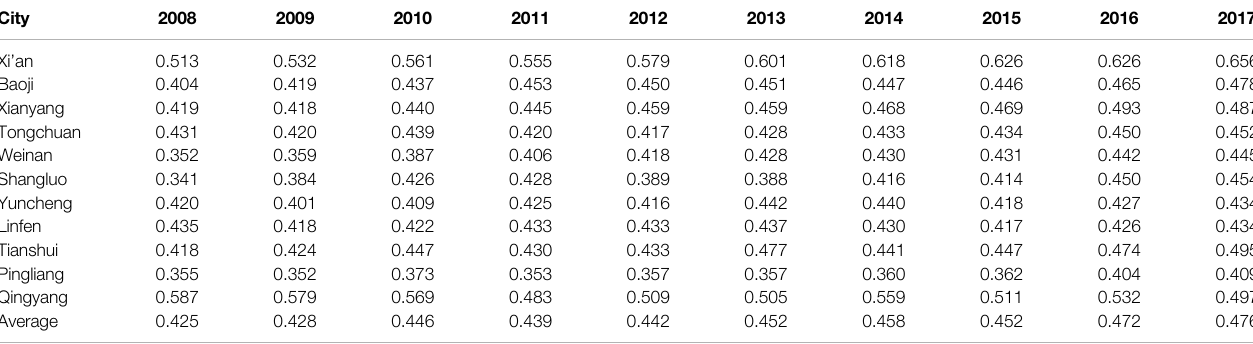
TABLE 4 | Summary table of coordination index of new-type urbanization and ecological environment of the GZPUA 2008 – 2017. City